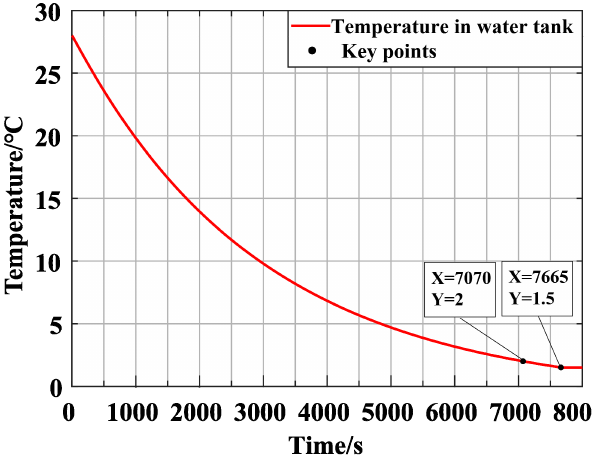
Figure 10. Simulation image of temperature curve in water tank.